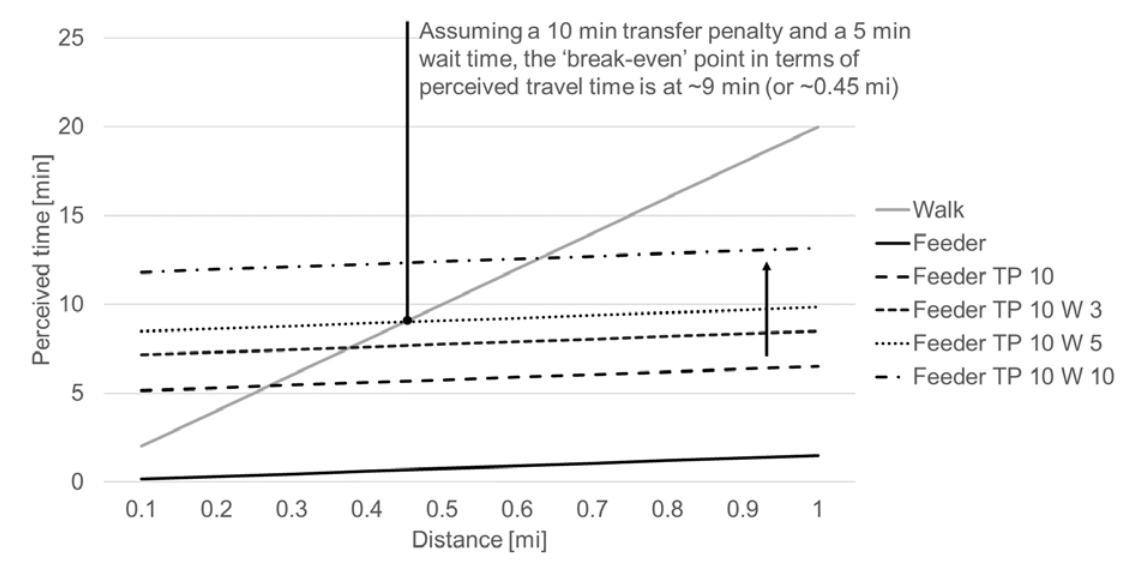
Figure 2. Travel time comparison for a first mile walk vs feeder service. Wait times and transfers are hypothesized to decrease the utility of feeder services on short